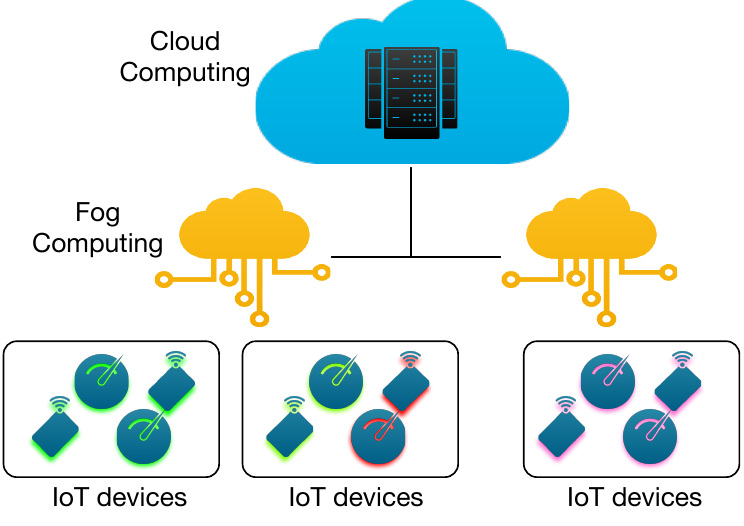
Figure 1. Fog and Internet of Things (IoT)